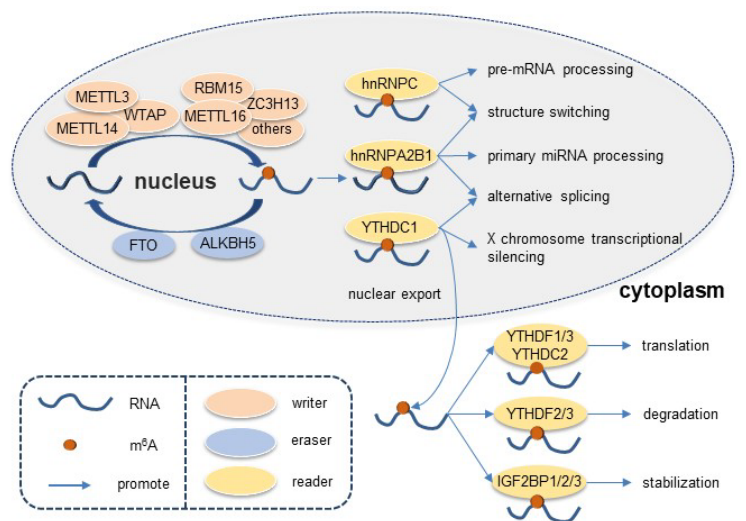
Figure 2. The process and molecular functions of RNA m 6 A methylation. M 6 A modification is dynamically installed by writers (METTL3, METTL4, METTL14, WTAP, RBM15, ZC3H13) and removed by erasers (FTO and ALKBH5). M 6 A sites are recognized by readers. hnRNPs and YTHDC1 are nuclear readers. hnRNPC binds to structurally altered RNAs and mediates pre-mRNA pro-